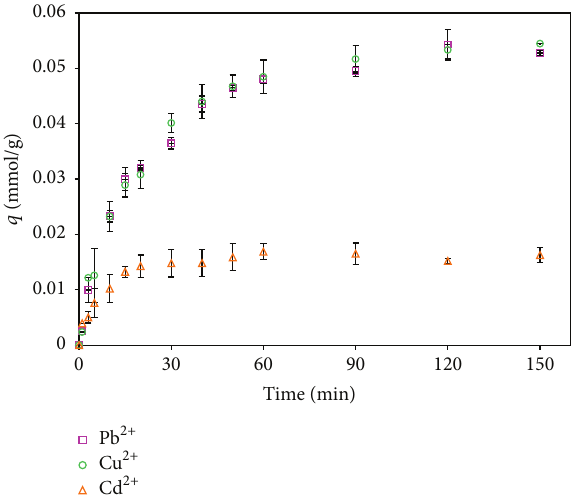
Figure 5: Equimolar multicomponent adsorption kinetics of SCG. Experimental conditions: 0.1mM initial equimolar metal concen- tration, pH 4.5, and 25 ∘ C. Error bars represent standard deviation of triplicate